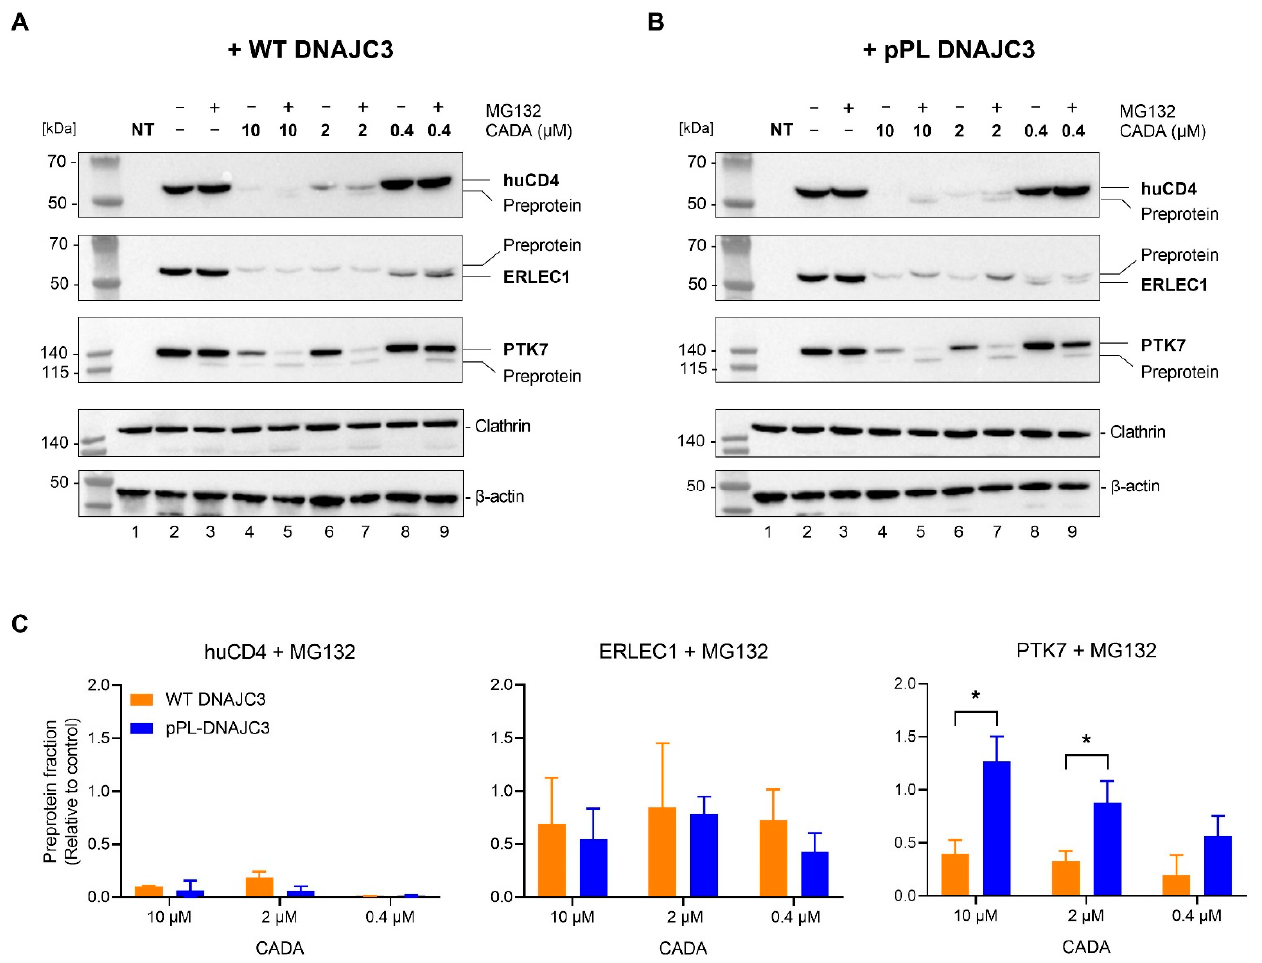
Figure 4. Inhibition of the proteasome in the presence of CADA rescues a preprotein fraction which is DNAJC3-dependent for PTK7. ( A ) Western blot images of cell lysates from non-transfected (NT) HEK293T cells, and huCD4-V5, ERLEC1-V5 or PTK7-V5, co-transfected with WT DNAJC3. Cells were treated for 24 h with different CADA concentrations and a constant dose of MG132 (200 nM). Protein bands were visualized with an antibody against the V5 tag, and an antibody against clathrin (huCD4 and ERLEC1) or β -actin (PTK7) was used for the cell loading controls. One representative experiment out of two to four is shown. The clathrin loading control shown is that of the ERLEC1 sample. The respective loading control for huCD4 is presented in Supplementary Figure S3E. ( B ) Same as in ( A ) but for co-transfection with pPL-DNAJC3. One representative experiment out of two to four is shown. ( C ) Preprotein fraction of MG132-treated samples quantified from ( A , B ) and normalised to the internal loading control of the respective sample. Bars are mean ± SE; n = 2 for huCD4 and PTK7; n = 4 for ERLEC1. Statistical analysis (multiple unpaired t -tests) showed increased detection of the PTK7 preprotein when co-expressed with pPL-DNAJC3 as compared to WT DNAJC3 (* = p < 0.05). HEK293T: human embryonic kidney 293T cells; huCD4: human CD4; ERLEC1: endoplasmic reticulum lectin 1; PTK7: inactive tyrosine-protein kinase 7; pPL: pre-prolactin; DNAJC3: DnaJ homolog subfamily C member 3; CADA: cyclotriazadisulfonamide; DMSO: dimethyl